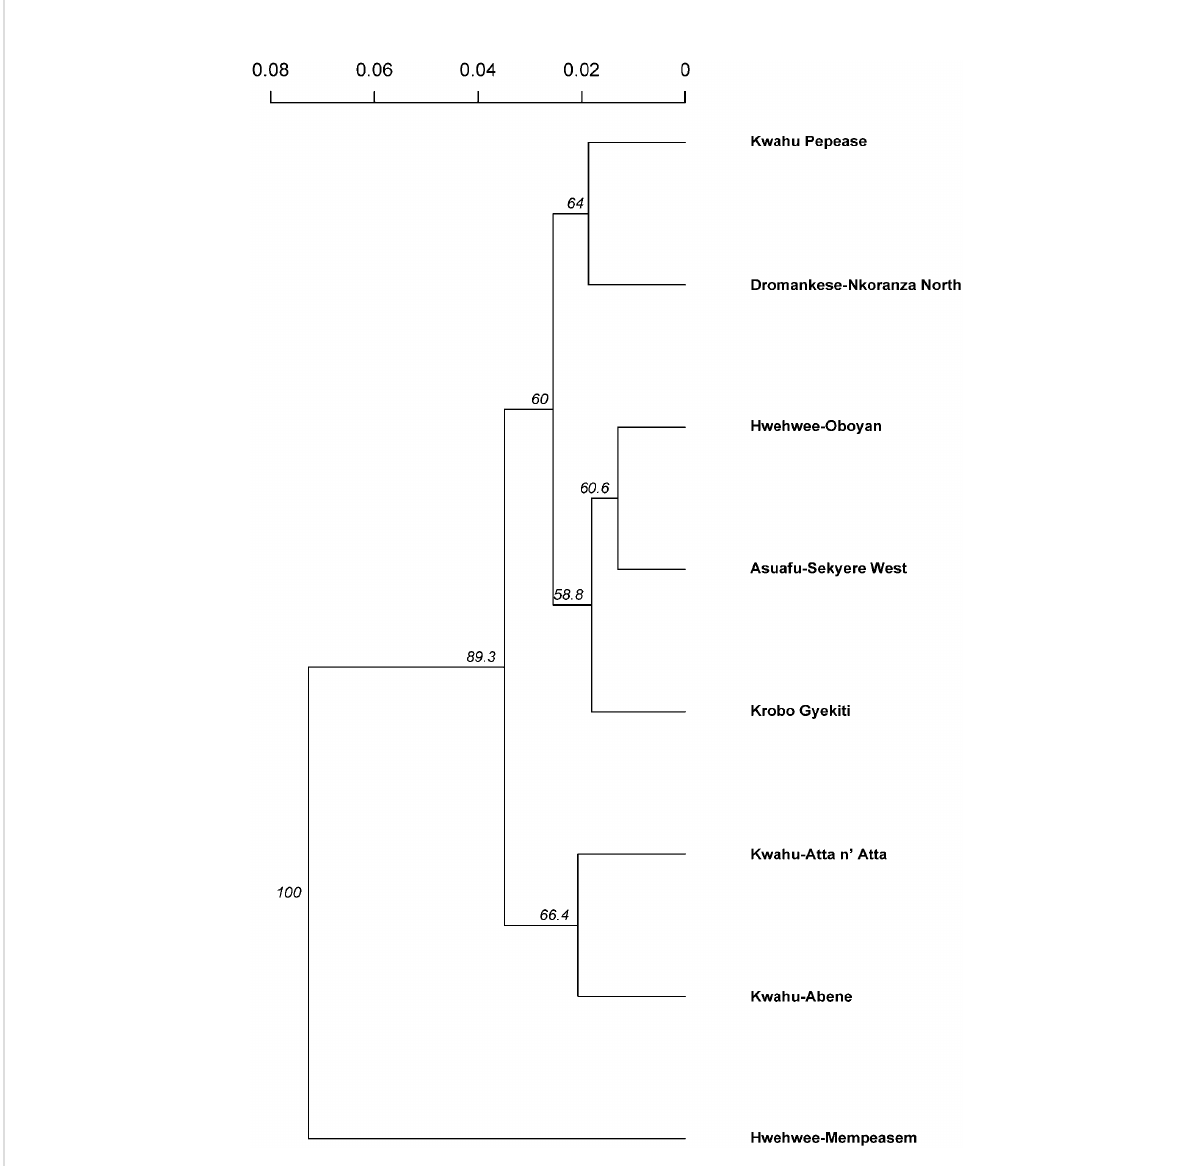
FIGURE 5 An unweighted pair group method with arithmetic mean (UPGMA) dendrogram of Cryptolepis sanguinolenta populations using 15 polymorphic microsatellite primers based on Bruvo ’ s genetic distance. Numbers indicate the percentage of bootstrap support using 1,000 replications (threshold set at